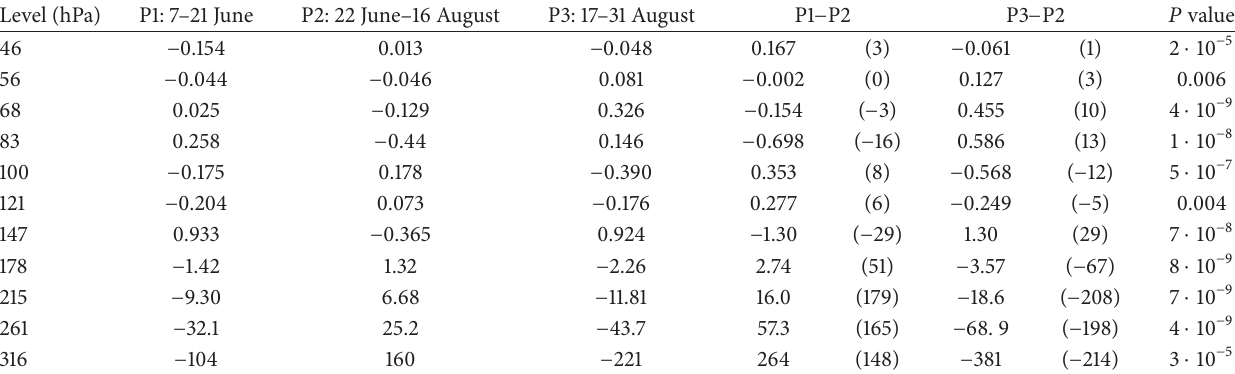
Figure 6: The time-height section of (a) water vapor anomalies in May–September 2010, calculated using MLS data centered at 65 ∘ N and 50 ∘ E, (b) the same, but for temperature. Table 4: Water vapor anomalies in the UTLS region (ppm) according to the MLS data, centered at 65 ∘ N, 50 ∘ E. The rest as in Table 3. Level